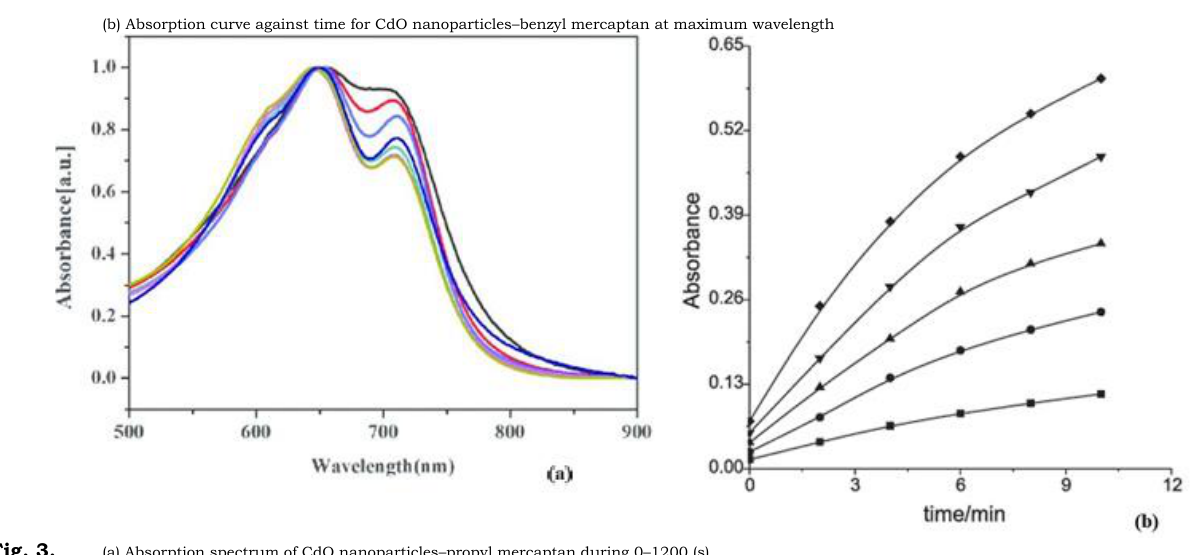
Fig. 3. (a) Absorption spectrum of CdO nanoparticles–propyl mercaptan during 0–1200 (s) (b) Absorption curve against time for CdO nanoparticles–propyl mercaptan at maximum wavelength The results show that aryl mercaptanes with shorter chain length. As can be seen in Figure (4), during 90 (s), chain length lead to faster aggregation of CdO nanoparticles phenyl mercaptanis emerged at higher wavelength (812.49 linked to DNA/RNA than ones with longer chain length. In nm) than phenyl (777.91 nm) and pentylmercaptanes (a other words, at shorter time, CdO nanoparticles is wide peak between 500–760 nm) and hence, aryl chains aggregated with aryl mercaptanes with shorter chain length with various chain length can be identified through at higher wavelength compared to absorption spectrum of controlling the aggregation time. CdO nanoparticles aggregated with aryl chains with longer